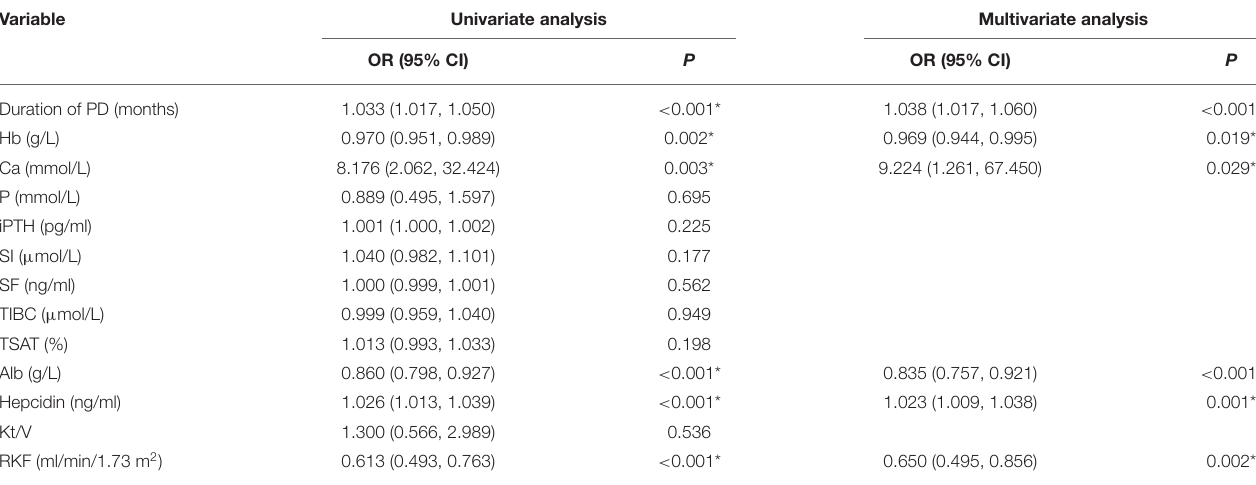
TABLE 2 | Univariate analysis and multivariate logistic regression model for RLS in PD patients. Variable Univariate analysis Multivariate analysis